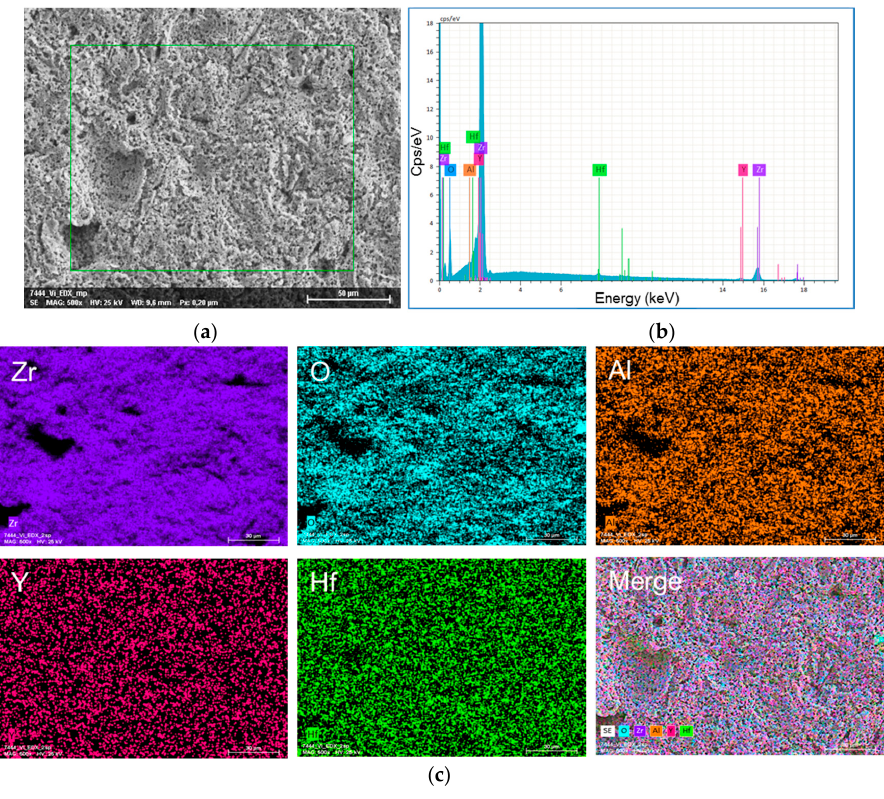
Figure 2. EDX analysis of the cer.face 14 surface. ( a ) Topographical scan, bar 50 µm, 500×; ( b ) Elemental composition; ( c ) In-depth analysis, bars 30 µm, main components Zr, O, Y, Hf, and Al.